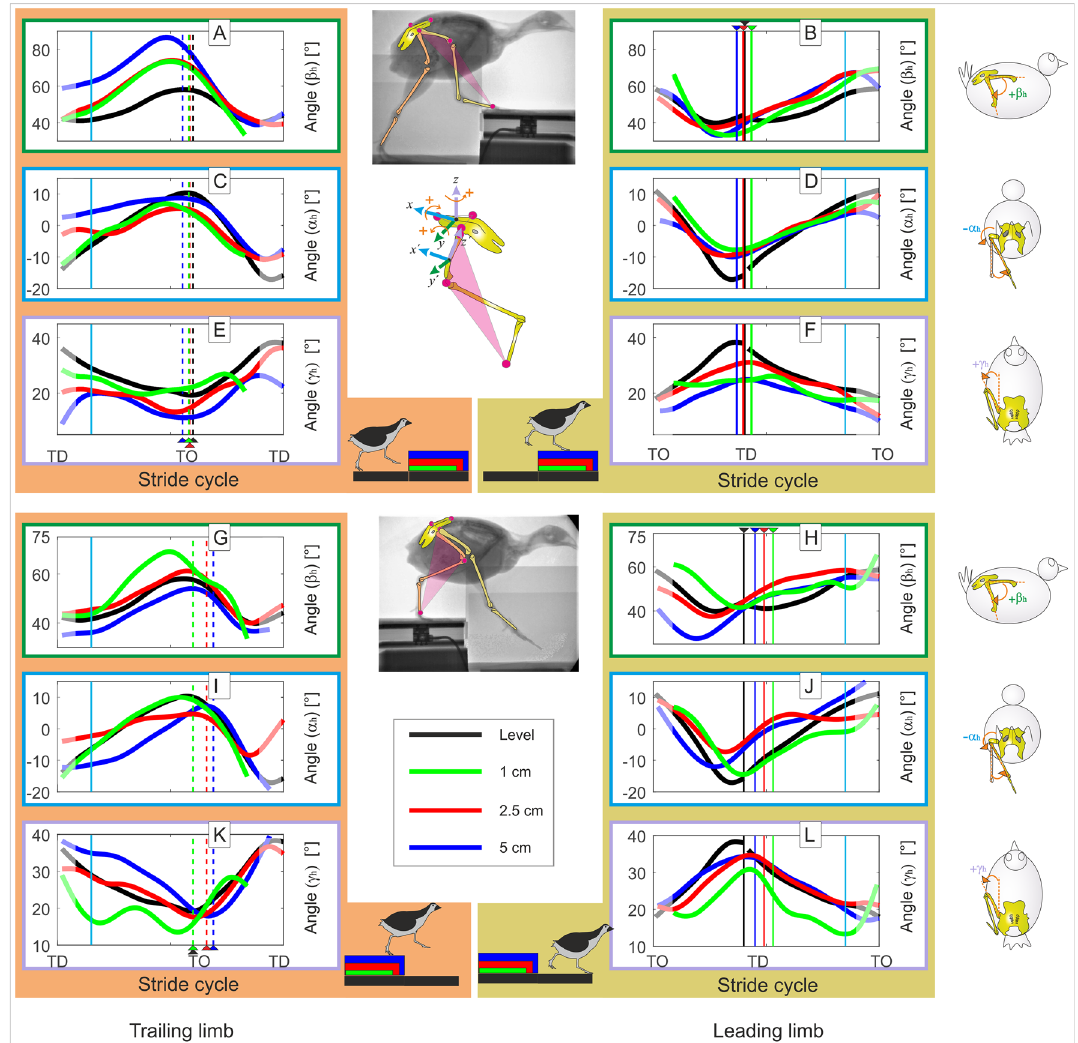
Figure 4. Whole leg three-dimensional rotations in the quail. Motions were measured relative to the pelvis. Level (black) and step locomotion (1 cm: green, 2.5 cm: red, 5 cm: blue). Accepting that the knee, the intertarsal and the tarsometatarsal–phalangeal joints work mainly as revolute joints, the plane describing the whole-leg displays the three-dimensional hip control. Level vs step-up (above): ( A , B ) hip flexion extension (β h ), negative values indicate flexion. ( C , D ) Hip mediolateral rotation (α h ). Positive values indicate that the distal point of the whole leg moves laterally with respect to the hip; and ( E , F ) hip ad-abduction (γ h ). Level vs drop (below): ( G , H ) hip flexion extension; ( I , J ) mediolateral rotation; and ( E , F ) hip Ad-abduction. Curves display mean values. Left: trailing leg stepping before the step up/downwards (stride i-1), right: leading leg stepping after the step up/ downwards (stride i). Black, blue, red, green dashed lines indicate toe-off (TO), while solid lines touch down (TD). Cyan solid lines indicate 15% and 85% of the stride. Due to the constrained field of view in the X-ray fluoroscope, hip data was often missing at the beginning and at the end of the stride cycles and average values might be less reliable (showed tions about the x-axis (α h ) reflect femoral axial rotations, resulting in the mediolateral rotation of the whole leg. α h = β h = γ h = 0° indicates that the whole leg and the pelvis coordinate systems are aligned. However, in this zero- pose, the pelvis and femur are orthogonal to each in the sagittal plane. Therefore, we used β h + 90° to represent hip flexion/extension in Fig. 4A,B,G,H and Tables S5 and S6. In the following, level locomotion is first described in detail. Step locomotion is discussed when there is a difference from level locomotion. Level locomotion, hip flexion–extension (β h ). At TD, the hip joint is flexed about 42°. After a small flexion due to weight transfer, the hip joint extends 17° until TO. After TO the leg protracts, flexing the hip joint up to 85% of swing. In the late swing phase, the whole leg retracts until TD (see Fig. 4A, black line).